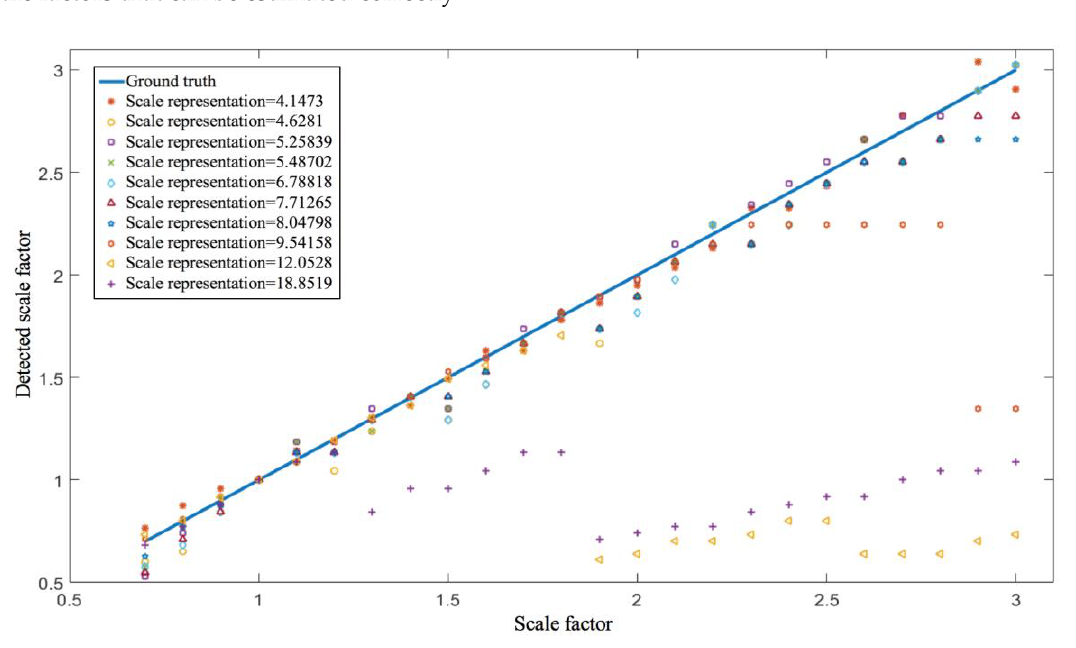
Figure 10. Three images (from left to right: Lena, Baboon, and Pepper) used for comparison between the SR-SYBA and the original SYBA algorithms. 4.2.1. Scaling Variation As for performance comparison under scaling variation, we first resized the image by 0.7–5.0 at a 0.1 interval, and tested the performance of these two algorithms for matching the resized image with the original. For a fair comparison, the same feature detector ORB was used for both SR-SYBA and SYBA. Brute Force matching [24] was performed for feature matching. Correct matches were filtered through the real affine matrix from which the error bound was set to 5 pixels. We define the